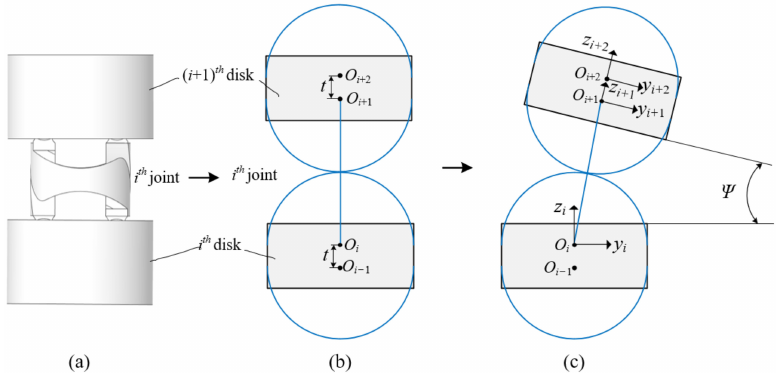
Figure 9. The joint coordinate system of a single joint. ( a ) The i th joint in the initial configuration. ( b ) The coordinate system in the initial configuration. ( c ) The coordinate system in the bending configuration.